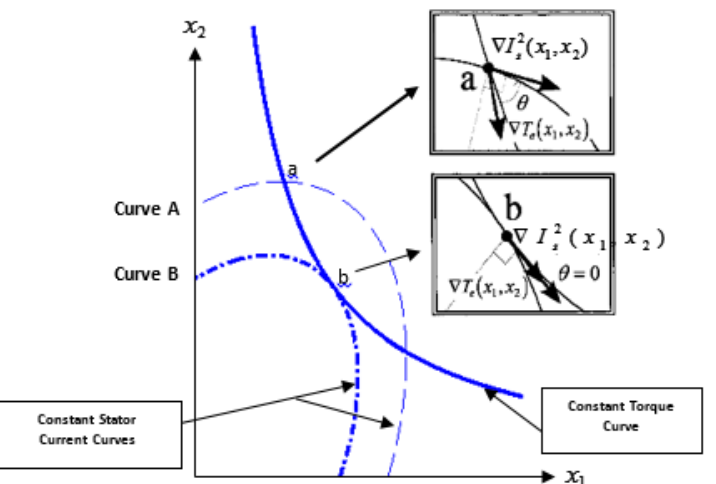
Figure 3. The geometric location of the constant torque and the constant stator current in the plane of biaxial currents of torque, adopted from [34].